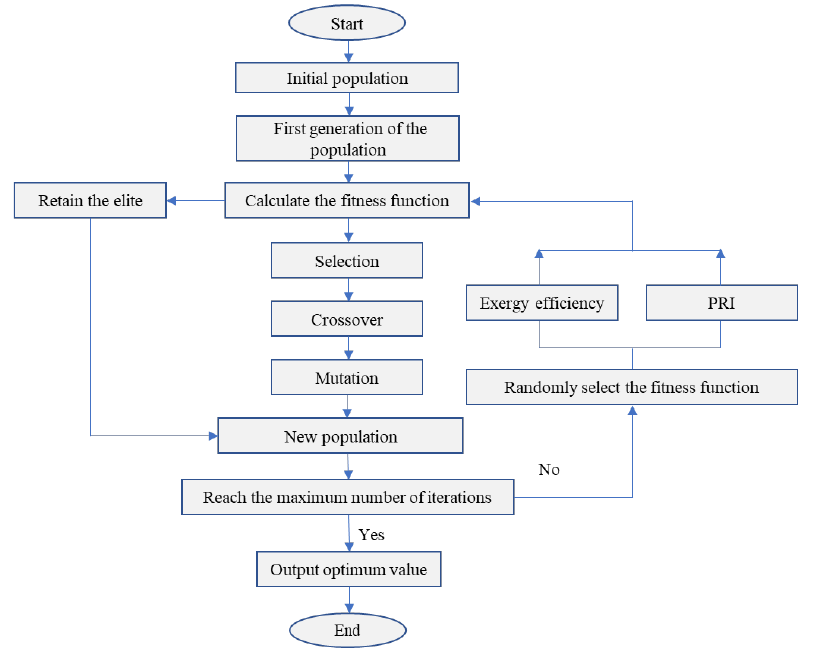
Figure 5. Implementation process of the genetic algorithm. Table 4. The parameters of the genetic